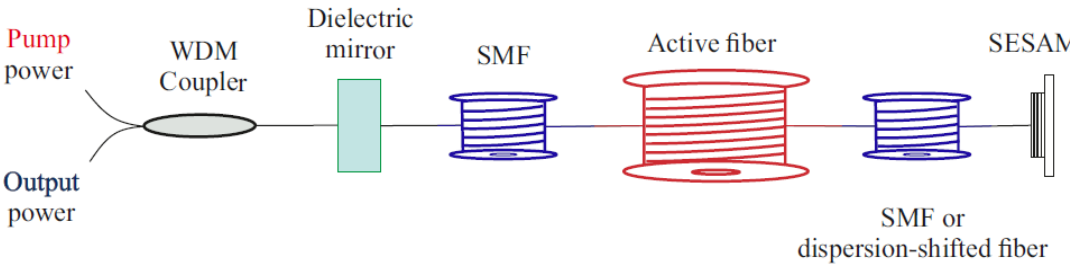
Figure 13. Typical linear mode-locked fiber cavity using SESAM.